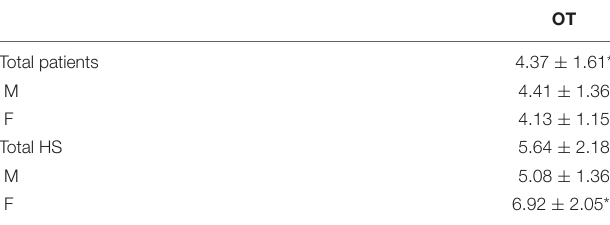
TABLE 2 | Plasma oxytocin (OT) levels (pg/ml, mean+SD) in patients with PTSD and healthy subjects (HS) (in the total sample and in the two